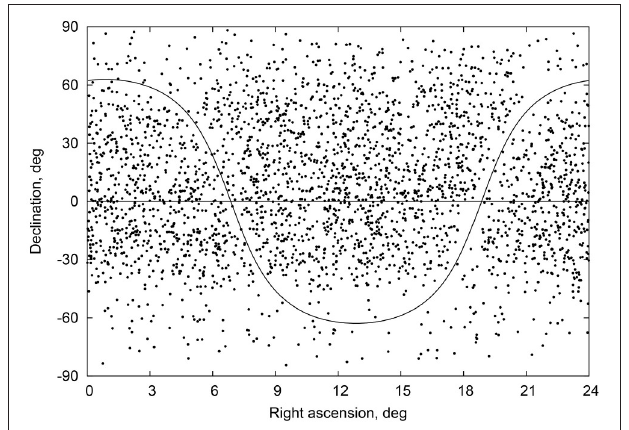
FIGURE 9 | Distribution of the gsf2015b sources with optical magnitude ≤ 20 m over the